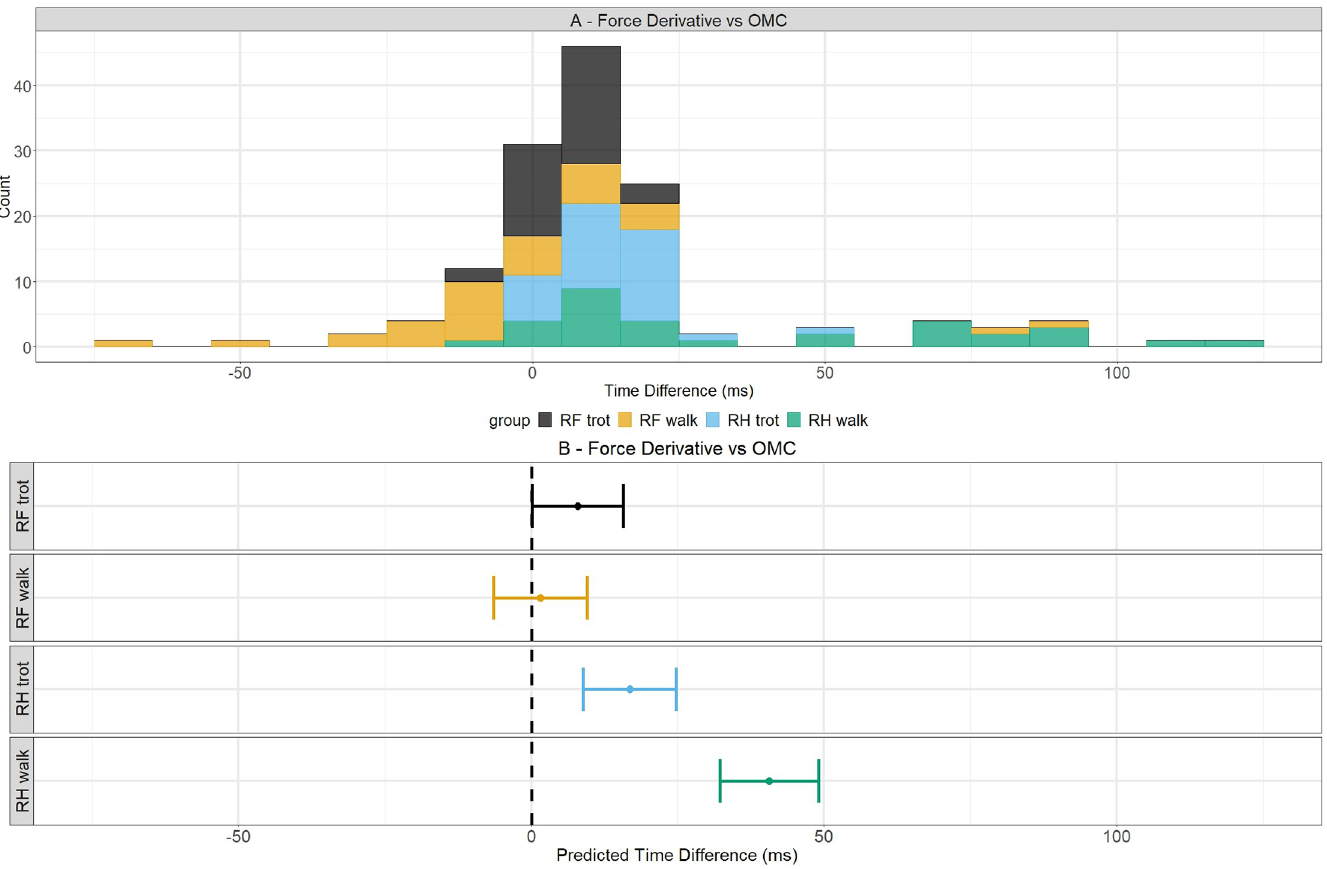
Fig 3. Time differences and predicted values of time differences between force derivative and OMC system for break-over phase onset detection. Time differences between the two reference methods are depicted in the upper figure with the different hoof/gait combinations depicted in their own color. In the bottom, the predicted values are indicated with dots for a certain hoof/gait combination and their 95% confidence intervals are shown by the whiskers. The dashed line indicates a predicted time difference of 0